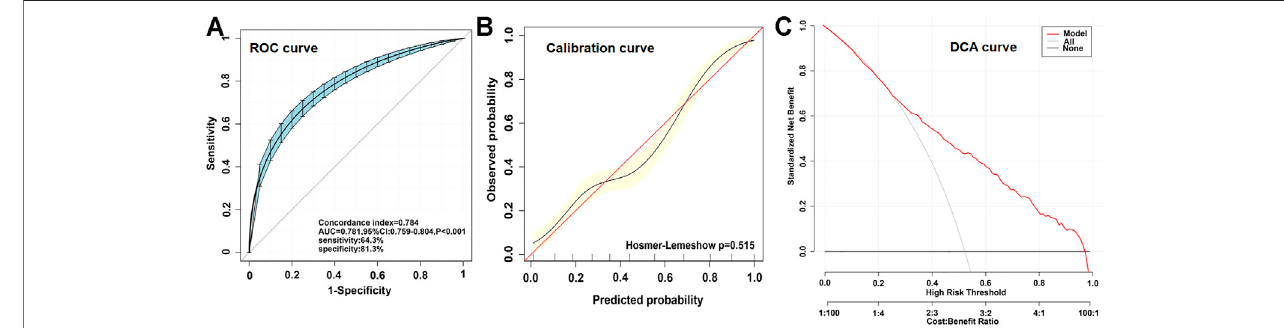
FIGURE 4 | Different parameters to validating the nomogram. (A) , receiver operation characteristic curve (ROC) for validating the discrimination power of the nomogram. (B) ,calibrationplotofthenomogram( p (cid:1) 0.515).Thediagonalredlinerepresentsaperfectpredictionbyanidealmodel.Thediagonal45 ° redlineindicatesa perfect calibration that the predictive capability of the model perfectly matches the actual risk of ACS. The black line represents the performance of the nomogram, of which a closer fi t to the diagonal red line represents a better prediction. (C) , decision curve analysis (DCA) of the nomogram. The x -axis indicates the threshold probability. The threshold probability is where the expected bene fi t of treatment is equal to the expected bene fi t of avoiding treatment. The y -axis measures the net bene fi t calculated by adding true positives and subtracting false positives. The gray line displays the net bene fi t of the strategy of treating all ACS patients. The black line illustrates the net bene fi t of the strategy of treating no ACS patients. The red line indicates the nomogram.